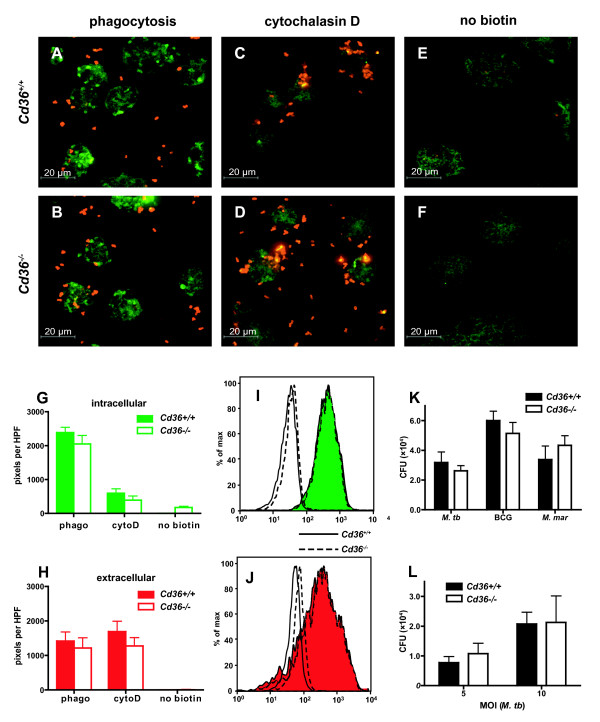
No difference in uptake of mycobacteria between Cd36+/+ and Cd36-/- macrophages. A to F. M. marinum was biotinylated and incubated with Cd36+/+ (top row) and Cd36-/- (bottom row) macrophages for 3 hours to allow phagocytosis. Extracellular M. marinum was labeled using streptavidin-conjugated tetramethylrhodamine (TMR) and appears red. Macrophages were fixed and permeabilized and a second streptavidin-conjugated fluorophore (AlexFluor488(c)) was used to label intracellular M. marinum (appears green). A and B. Intracellular (green) M. marinum is readily visible within Cd36-/- macrophages, with uptake qualitatively equivalent to Cd36+/+ macrophages. C and D. Control conditions using cytochalasin D (10 μM) to inhibit phagocytosis, demonstrating decreased intracellular (green) mycobacteria in both Cd36+/+ and Cd36-/- macrophages. E and F. Control conditions using unbiotinylated mycobacteria, demonstrating the specificity of fluorescent labeling for mycobacteria. G and H. Image analysis demonstrates similar quantities of intracellular (G, green) and extra cellular (H, red) M. marinum (p = 0.29) in Cd36+/+ and Cd36-/- macrophages. I and J. Flow cytometry showed no significant difference in the fluorescence intensity associated with intracellular (green) or extracellular (red) M. marinum between Cd36+/+ (solid line) and Cd36-/- (dashed line). Shown for comparison are negative control conditions (unbiotinylated M. marinum, no fill color). K and L. In vitro, Cd36+/+ and Cd36-/- macrophages showed similar uptake of three mycobacterial species, M. tuberculosis (MOI = 10:1), M. bovis BCG (MOI = 10:1) and M. marinum (MOI = 1:1) (p > 0.05 for all species). Similar uptake was observed at different multiplicities of infection with M. tuberculosis (p > 0.05 for each MOI).